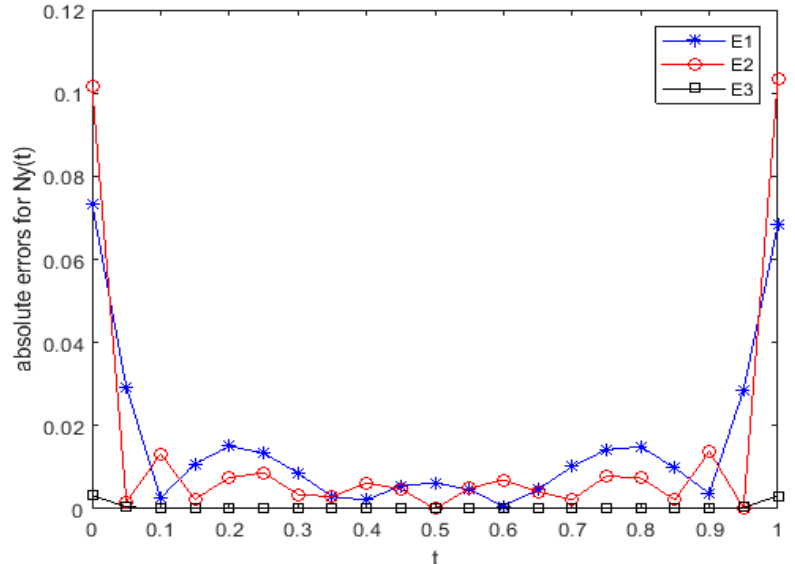
Figure 18. Errors for N y ( t ) at m = 3, 6 and 9, with parameters: α = β = γ = 1, w 0 = 1, T 1 = 1, Figure 18. Errors for 𝑁 (cid:3052) (𝑡) at 𝑚 = 3,6 and 9 , with parameters: 𝛼 = 𝛽 = 𝛾 = 1 , 𝑤 (cid:2868) = 1 , 𝑇 (cid:2869) = 1 , 𝑇 (cid:2870) = T 2 = 20, a = 1, b = 20, 𝑎 = 1, 𝑏 = 1 . Figure 18. Errors for 𝑁 (cid:3052) (𝑡) at 𝑚 = 3,6 and 9 , with parameters: 𝛼 = 𝛽 = 𝛾 = 1 , 𝑤 (cid:2868) = 1 , 𝑇 (cid:2869) = 1 , 𝑇 (cid:2870) = 20, 𝑎 = 1, 𝑏 = 1 .